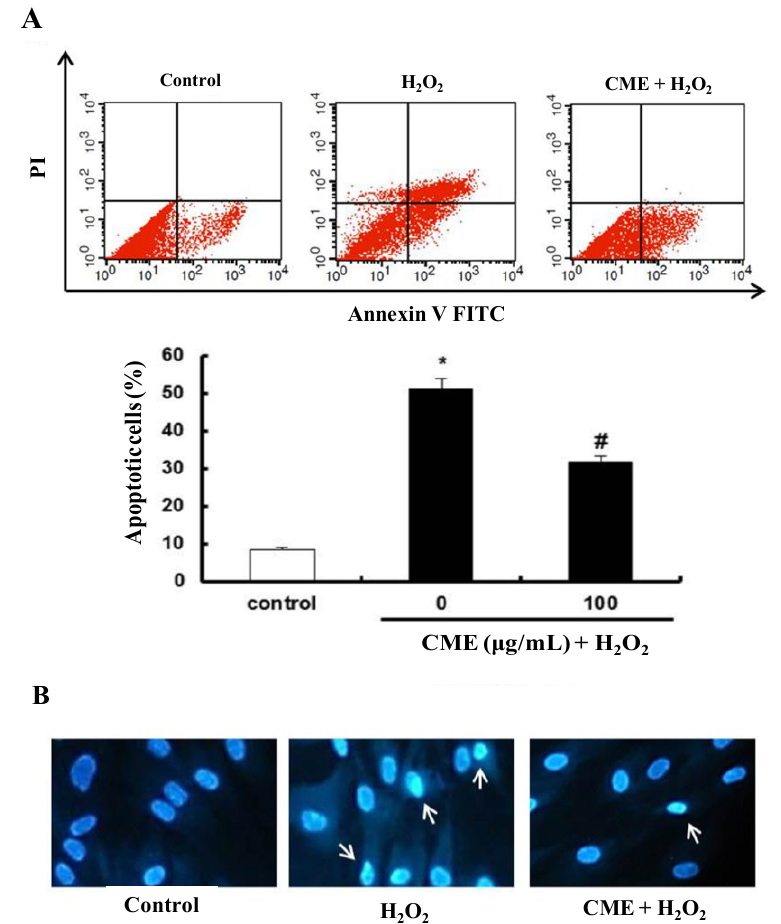
Figure 5. Protective effect of CME on hydrogen peroxide-induced apoptosis in HDFs. ( A ) Apoptotic cells were detected by annexin V and PI double staining and analyzed by flow cytometry. The conditions were control (no treatment), 0.8 mM H 2 O 2 for 3 h, and 0.8 mM H 2 O 2 for 3 h with CME (100 μg/mL). The bottom graphs represent the percentage of apoptotic-cell death as indicated by the total number of cells in the upper right and lower right quadrants. Data represent the mean ± SE of three independent